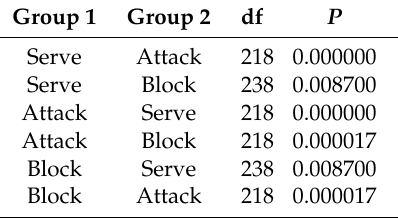
Table 3. Di ff erences between average jump flying distance values during serve, attack, and block.